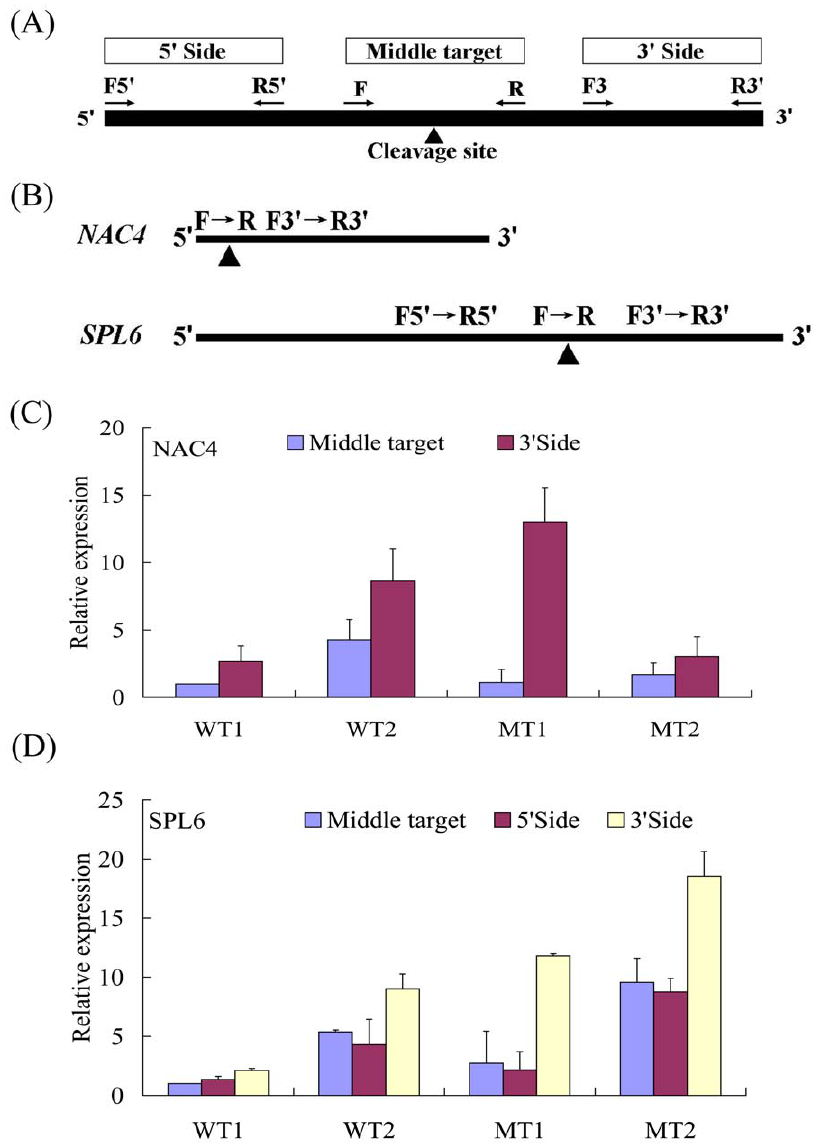
Figure 7. Diagram of regional amplification quantitative RT-PCRs (RA-PCR) and Stage-specific RA-PCR of miRNA-targeted NAC4 and SPL6 . (A) Diagram of primers designed to amplify fragments of cleaved and noncleaved miRNA (miRNA)-targeted mRNA present in tissues. miRNA target sites ( m ); (B) Real-time PCR for sense and antisense expression of selected miRNA targets; (C) Relative quantification of two fragments of NAC4 (target of Novel29) by RA-PCR with the middle target fragment being set to a value of 1; (D) Relative quantification of two fragments of SPL6 (target of Novel56) by RA-PCR with the middle target fragment being set to a value of 1. Data points represent the mean 6 SE of at least four replications for the relative expression, which were calibrated by the amount of the b -actin control